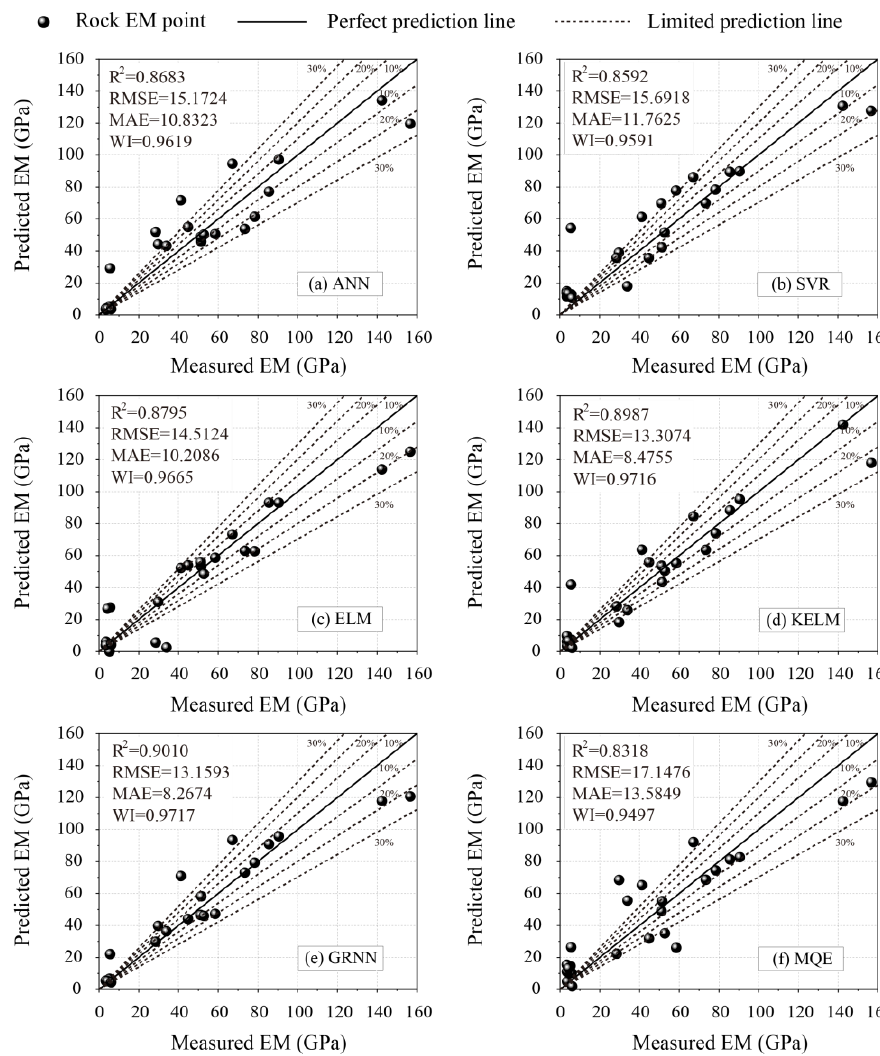
Figure 10. Regression diagrams of the other six models for predicting the rock EM.